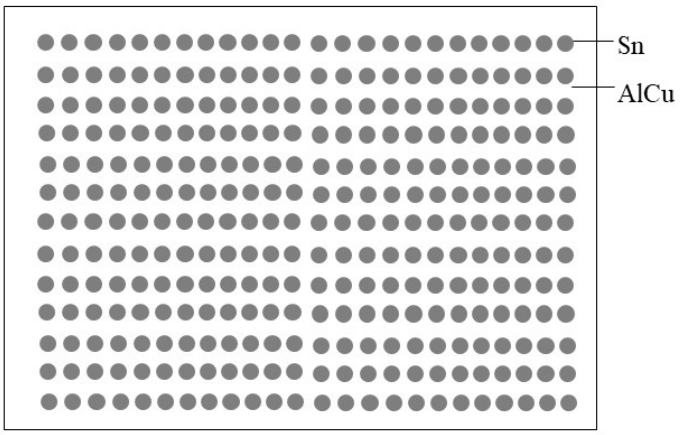
Figure 19. Ideal distribution of the tin phase in an aluminum–tin alloy.